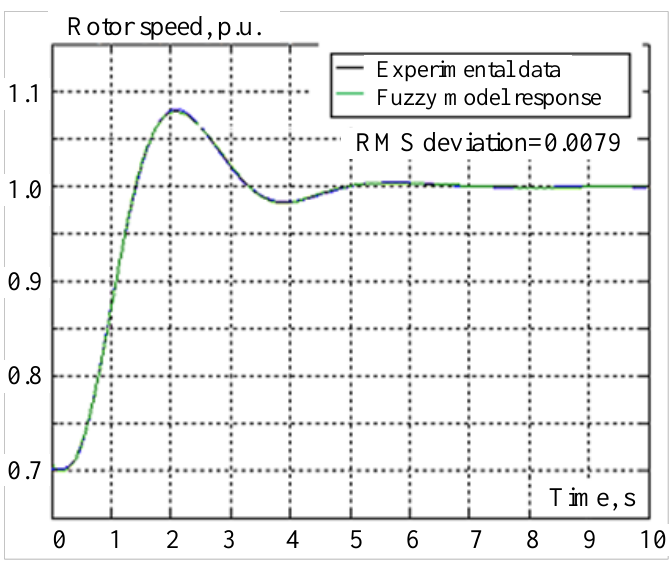
Figure 18. Results of a comparison of a fuzzy model (25 rules) with experimental data.